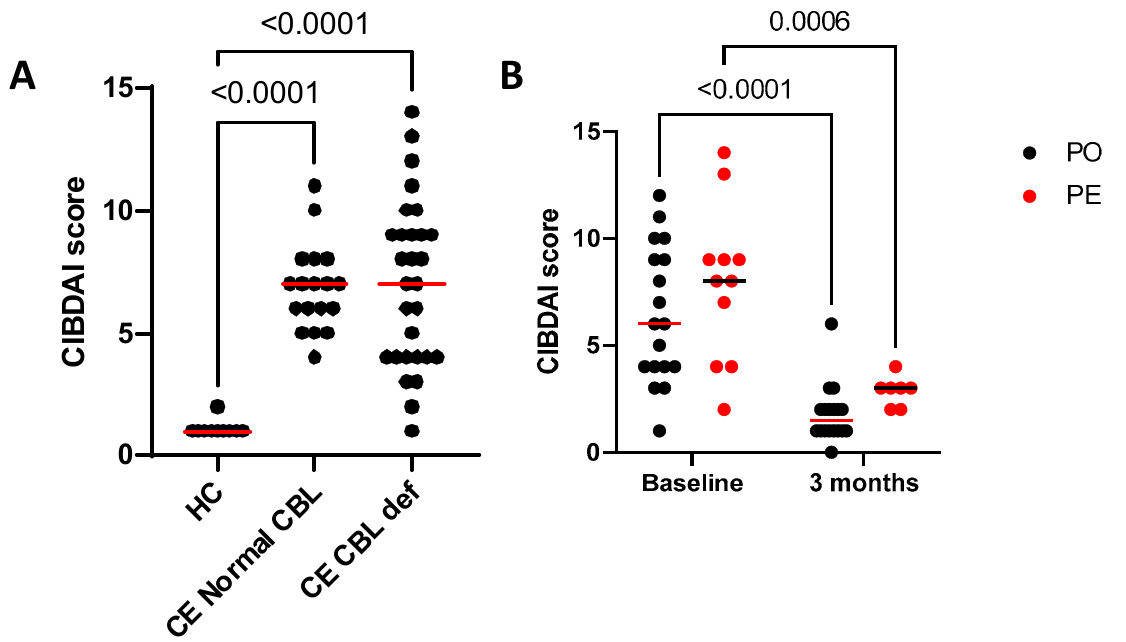
Figure 1. Canine Inflammatory Bowel Disease Activity Index (CIBDAI) scores from ( A ) chronic enteropathy (CE) dogs with cobalamin (CBL) deficiency (CE CBL def) or normocobalaminemia (CE Normal CBL) at inclusion, compared to healthy controls (HC). Scores were significantly higher in dogs with CE CBL def and CE Normal CBL compared to HC ( p < 0.0001 for both). No difference was observed between CE CBL def and CE Normal CBL ( p = 0.99). ( B ) CIBDAI scores from CE dogs with cobalamin deficiency at inclusion and after 3 months of cobalamin supplementation (combined with appropriate therapy on a case-by-case basis), separated by route of administration (oral, PO, or parenteral, PE). No difference was observed between groups at baseline ( p = 0.273) or at 3 months ( p = 0.580). CIBDAI scores decreased significantly in both groups at 3 months compared with baseline (PO p < 0.0001; PE p =